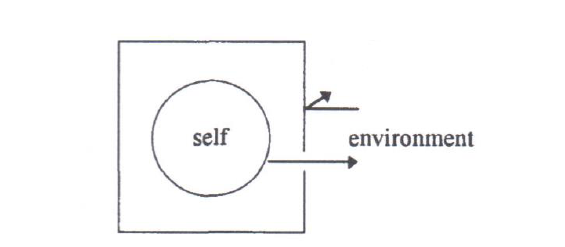
Figure 25: Compulsive Caregiver (Evans 1998 p.